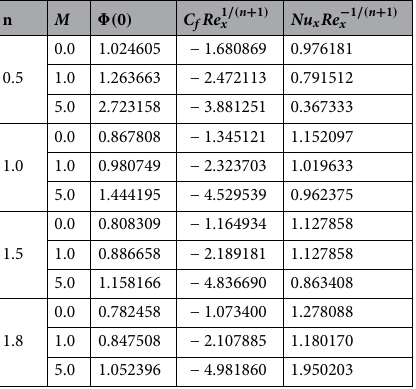
− 1 /( n + 1 ) x for various physical